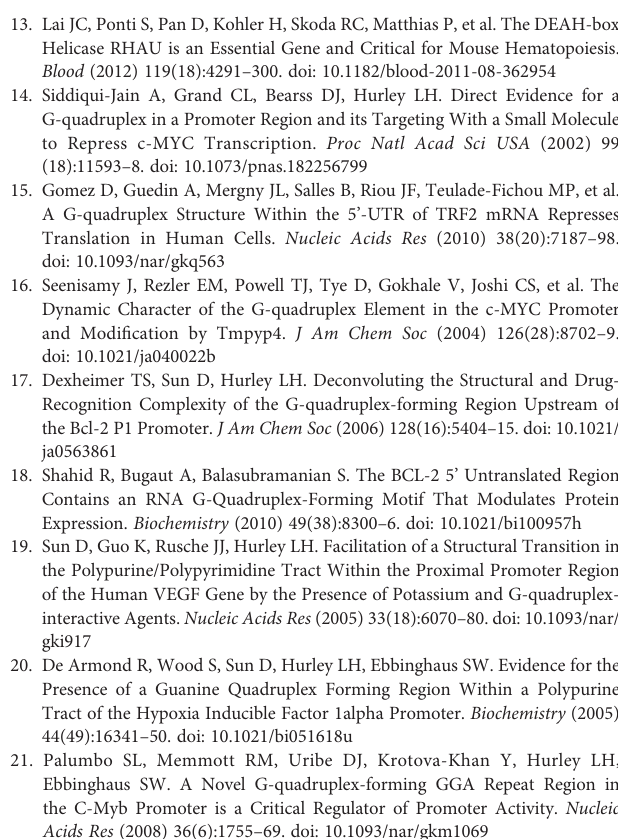
Supplementary Figure 1 | Pan-cancer analysis of DHX36 gene expression. (A) Analysis using the GEPIA bioinformatic server. (B) Analysis using the cBioPortal for Cancer Genomics. Supplementary Figure 2 | Additional analysis of the gene and protein expression levels of DHX36 in lung cancer. (A) The breakdown meta-analysis of the differential expression of DHX36 gene in lung cancer tissues using the Lung Cancer Explorer (http://lce.biohpc.swmed.edu). (B) Paired comparison of DHX36 gene expression in a gene microarray study (GSE18842). (C) The analysis of the DHX36 protein levels in lung cancer using the Clinical Proteomic Tumor Analysis Consortium (CPTAC). Supplementary Figure 3 | Initial cytotoxicity assay of the celllines in response to cisplatin for the determination of the optimumdose for apoptosis detection. (A) Raw fl uorescence reads of viable cells indicatedby the Alamar Blueassay. (B) Normalised cellviability